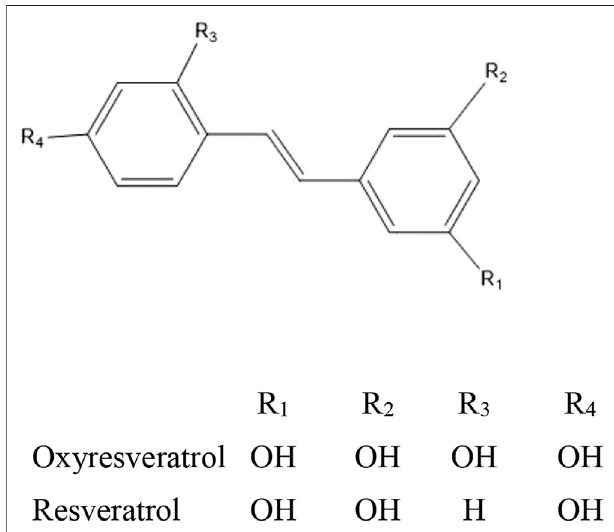
FIGURE 1 | Chemical structure of OXY and resveratrol.